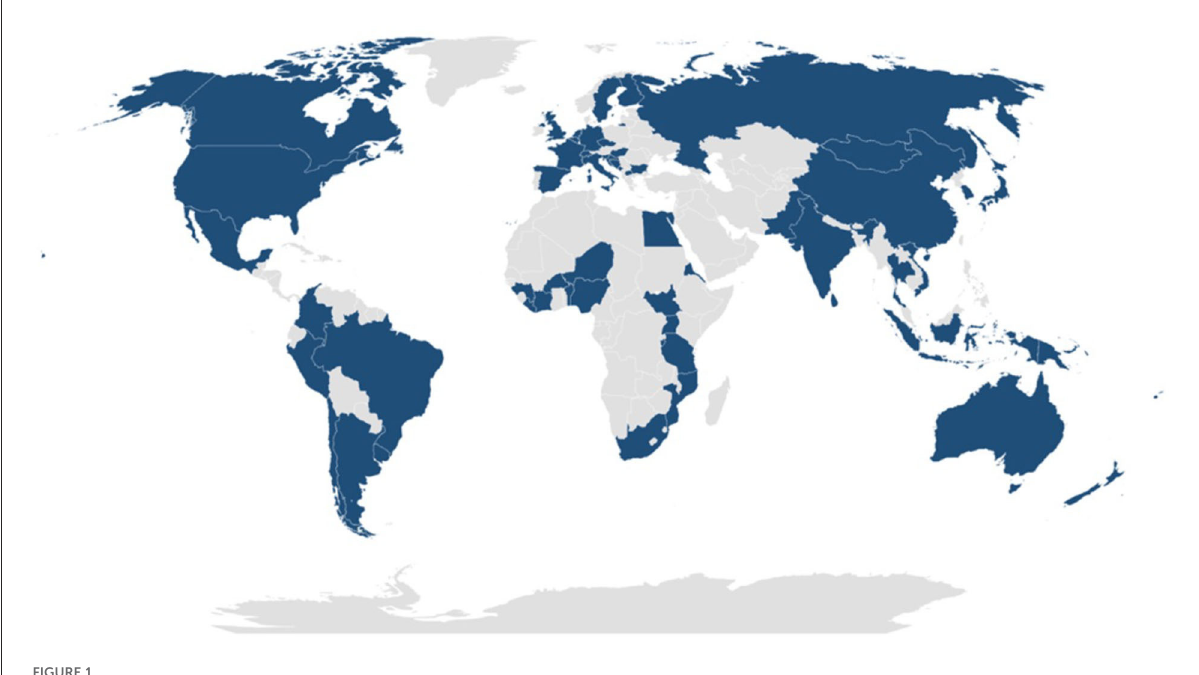
FIGURE1 Countries included in this